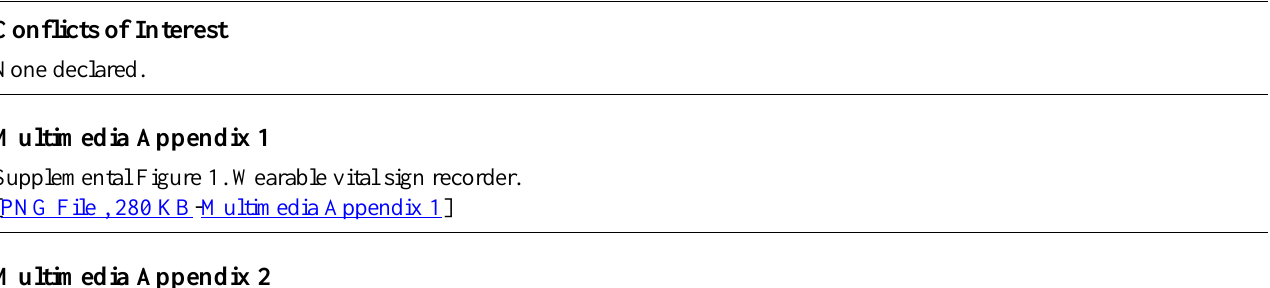
Supplemental Figure 2. Integration of data from the wearable vital sign device into the SNUH HIS.